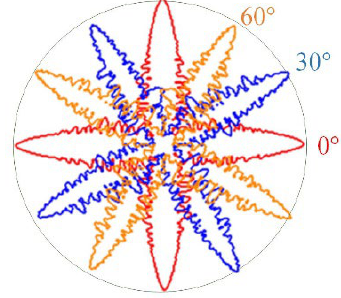
Figure 7. Velocity symmetry in different orientations.